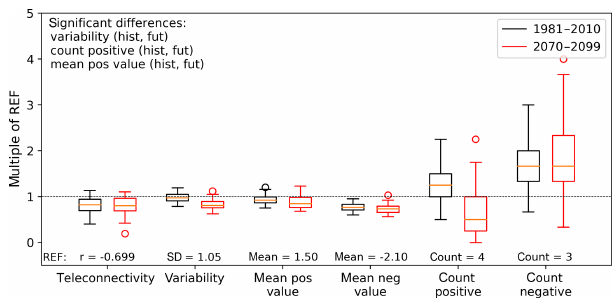
Figure 9. Several index statistics of all 50 CanESM2-LE members expressed as multiples of the respective ERA-I value (ERA-I value set to 1.0): teleconnectivity (Pearson correlation between AH and IL time series), index variability (expressed as temporal standard deviation of index time series), mean value of all positive (negative) phases and count of all positive (negative) phases per realization. Positive (negative) years are defined by an absolute index value ex- ceeding 1. Text denotes combinations of which the differences are significant at p ≤ 0 . 05 using an unpaired Mann–Whitney/ U test. Orange line in boxplots is the